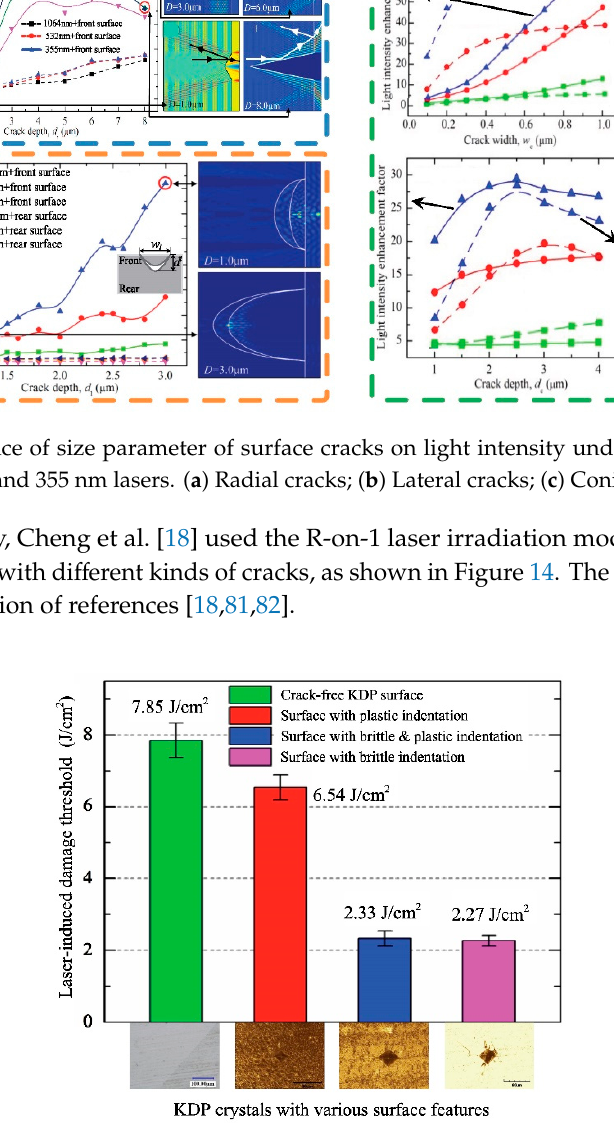
Figure 14. Experimentally tested laser induced damage thresholds (LIDTs) for crack-free and flawed KDP surfaces [18].